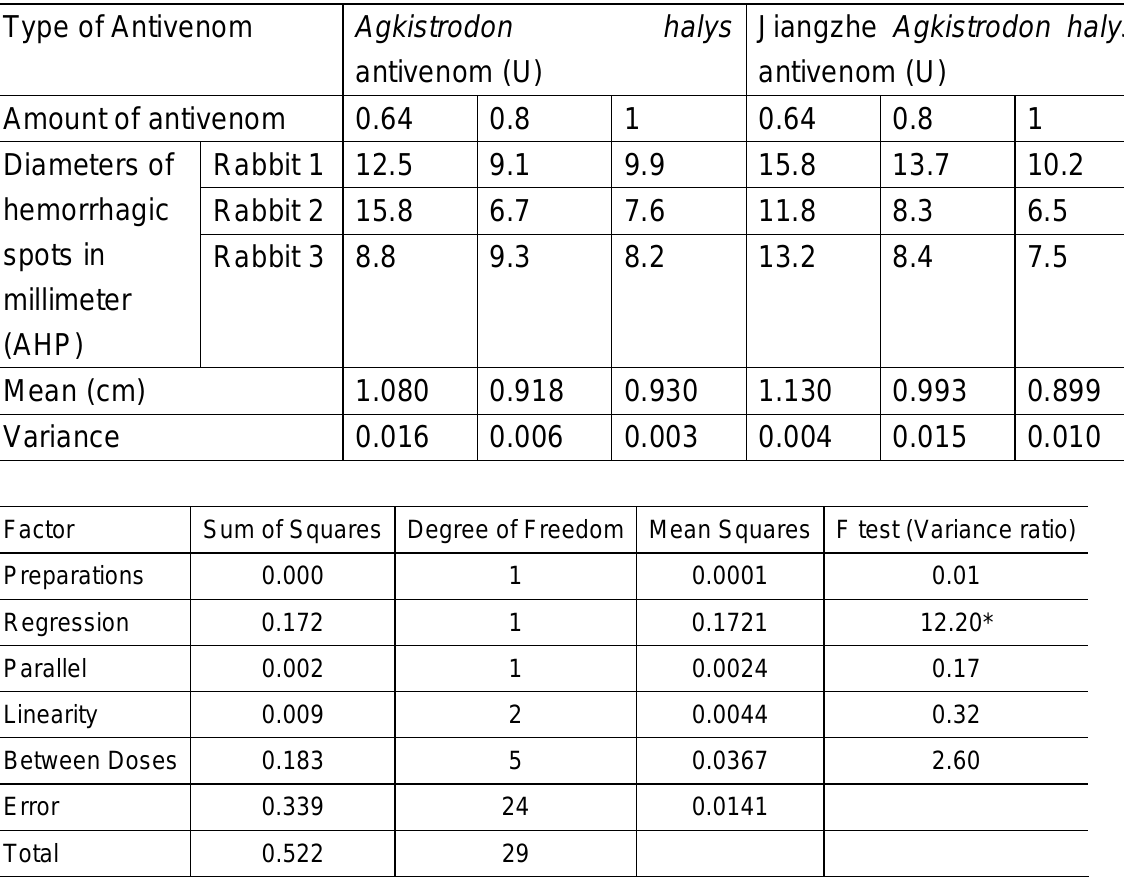
Table 5: Determination of the Hemorrhagic Test Dose of the venoms tested in rabbits. Antivenoms Venom (µg) Agkistrodon halys Jiangzhe Agkistrodon halys The test dose of a venom was expressed as g / 2.5 kg rabbit.